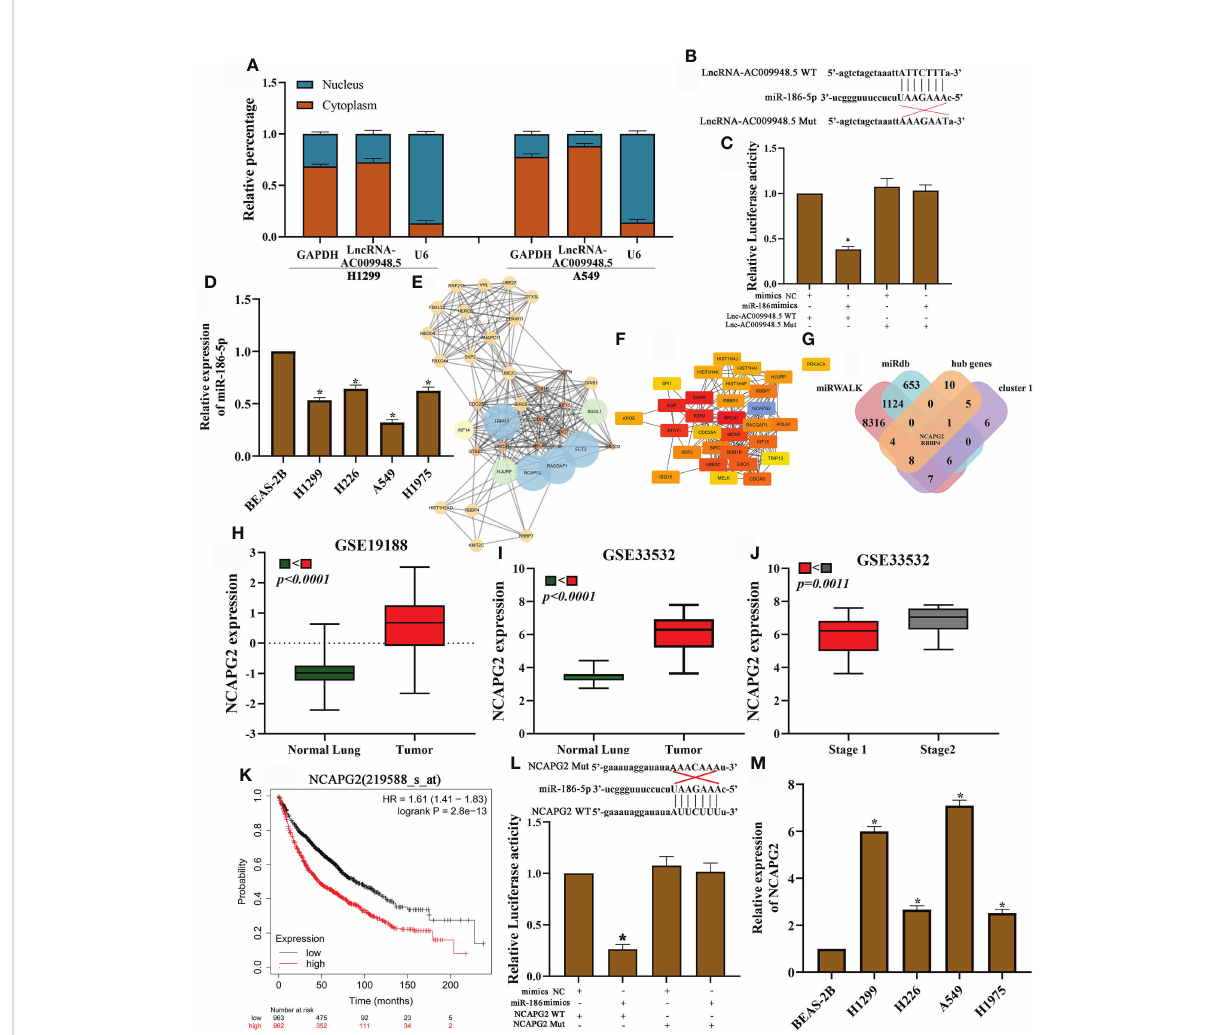
FIGURE 3 LncRNA-AC009948.5 by sponging miR-186-5p to regulate NCAPG2 expression. (A) Cytoplasmic and nuclear LncRNA-AC009948.5 expression detected by qRT-PCR. U6 and GAPDH acted as nuclear and cytoplasmic reference genes, respectively. Relative expression measured by the 2 - (cytoplasmic Ct value - nuclear Ct value) method. (B) Sequence alignments between LncRNA-AC009948.5 and seed sequences of miRNAs. wt, wild- type; Mut, mutant sequence. (C) Dual luciferase reporter gene assay to detect the interaction between LncRNA-AC009948.5 and miR-186-5p. (D) miR-186-5p expression in different cell lines detected by qRT-PCR. All experiments were repeated independently three times. (E) Function clusters determined by the MCODE algorithm (MCODE score=15). (F) The top 20 hub genes are based on protein-protein interaction network analyses by cutohubba. (G) The Venn diagram shows the overlap between the target genes of miR-186-5p, cluster 1 and hub genes. (H) NCAPG2 was highly expressed in NSCLC tissues as compared to the normal ones by GSE19188 dataset. (I) NCAPG2 was highly expressed in NSCLC tissues as compared to the normal ones by GSE33532 dataset. (J) High NCAPG2 expression was associated with advanced clinical tumor stage. (K) Kaplan-Meier analysis for overall survival based on differential expression levels of NCAPG2 in patients with lung adenocarcinoma. (L) Dual luciferase reporter gene assay to detect the interaction between NCAPG2 and miR-186-5p. Mimic NC, empty vector control; mimic, miR- 186 mimic. (M) NCAPG2 expression in different cell lines was detected by qRT-PCR. All experiments were repeated independently three